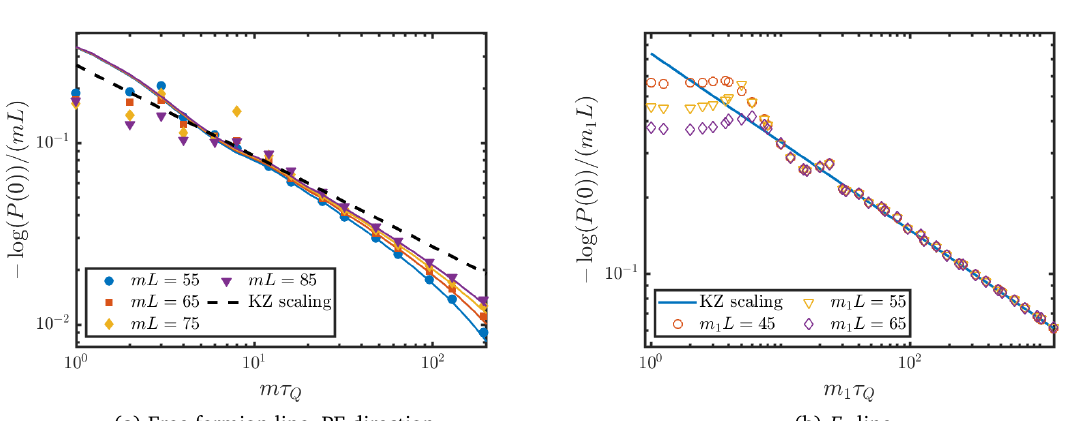
Figure 3.6: Logarithm of the probability of adiabaticity after a linear ramp along the two integrable lines of the Ising Field Theory. (a) Continuous lines and symbols of the same colour denote analytical and extrapolated TCSA data, respectively for various volume parameters. Black dashed line denotes the KZ scaling. At the onset of adiabaticity finite volume results deviate from the KZ slope and each other in a more pronounced manner. (b) Symbols stand for extrapolated TCSA data and the slope of the continuous line signals the KZ scaling